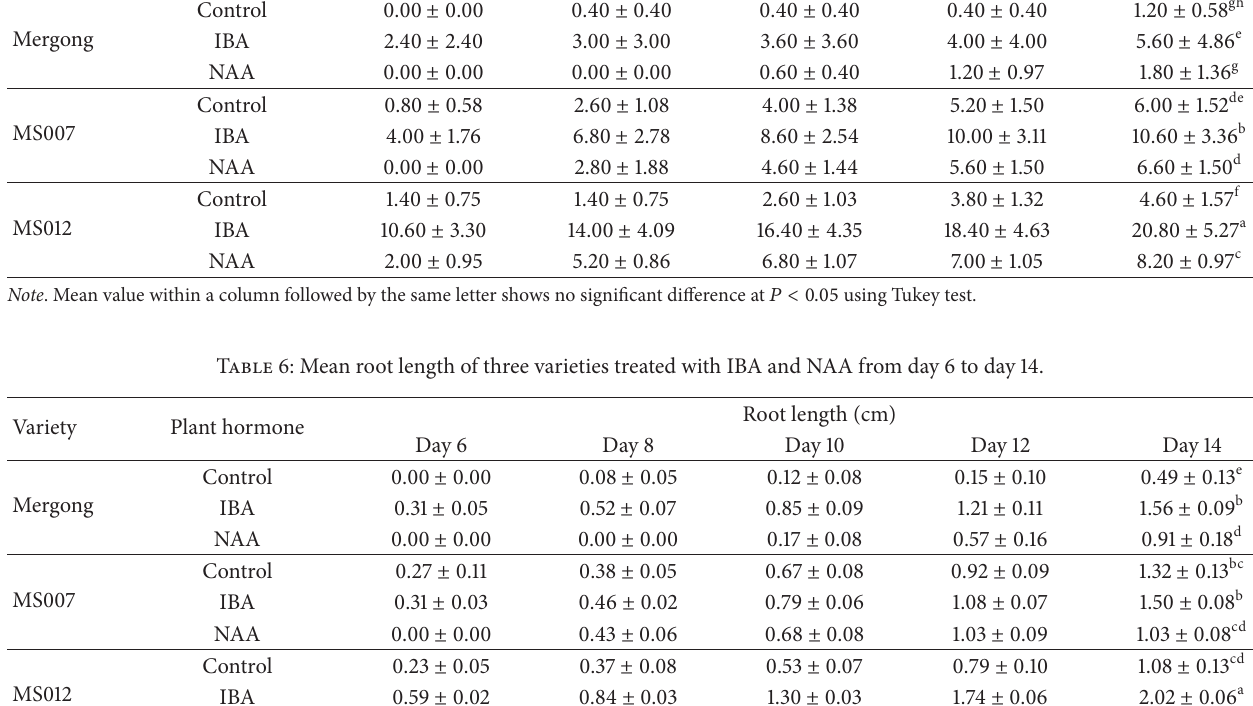
Table 5: Mean root number of three varieties treated with IBA and NAA from day 6 until day 14 in mist-chamber propagation box. Variety